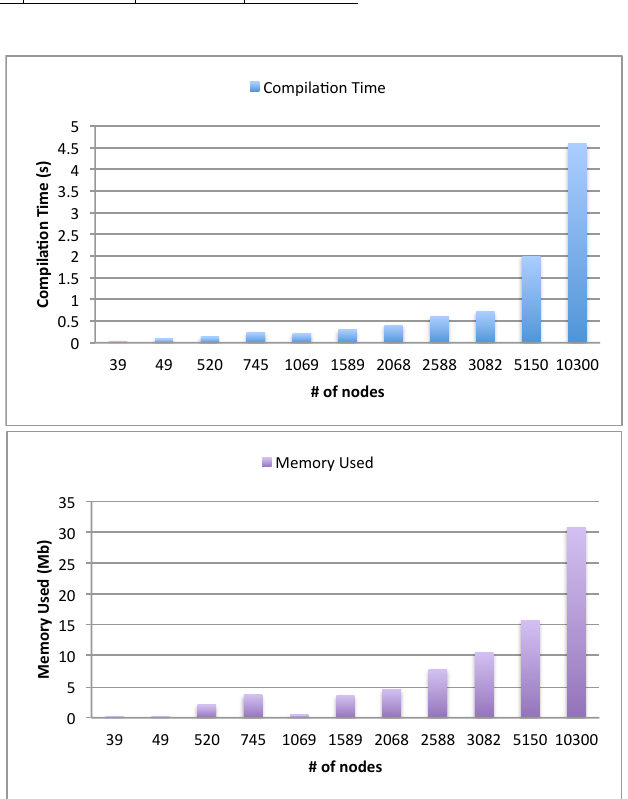
Figure 9. Time and Memory Used for BN